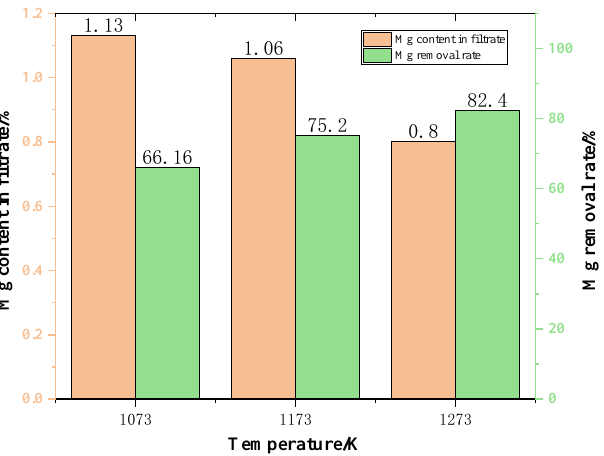
Figure 13. The effect of temperature on the content of Mg in the filtrate and on Mg removal rate.